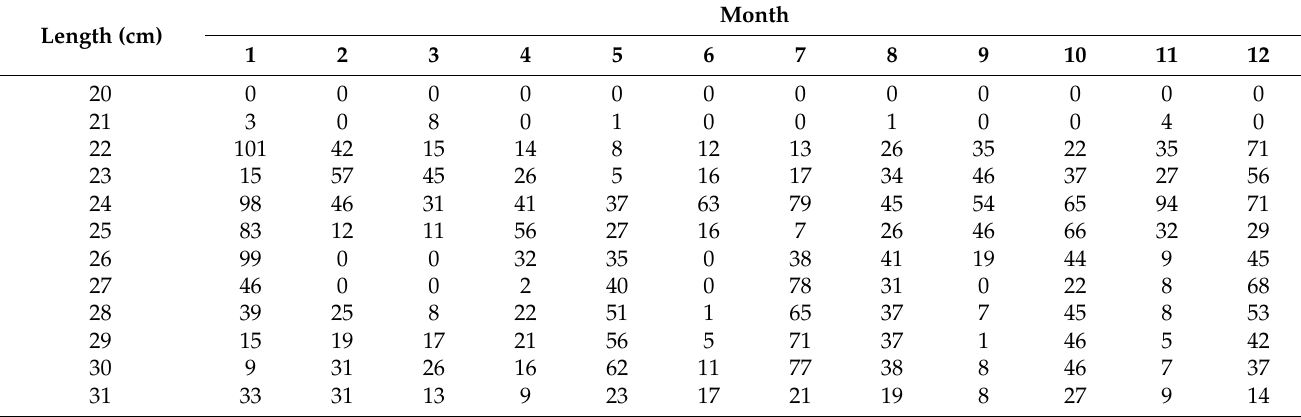
Table 1. Size distribution of Sardina pilchardus (unsexed, expressed in centimeter) specimens (n = 3951) collected in Northern Senegal in landing sites (2015; n = 987) and during scientific cruises at sea (2007, n = 2153; 2008, n =